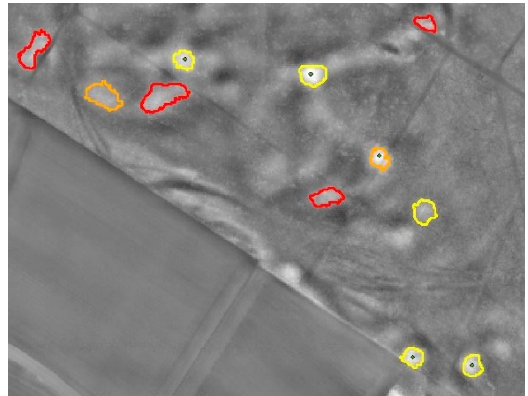
Figure 18. Classification results of Burial Mounds in Haltern. Members from the following classes are presented (Table 8); 3 (yellow), 4 (orange) and 5 (red). Mounds with a dot are included in the reference dataset. The yellow traced mound on the right side without a dot inside is considered as a new discovery ( new positive ) [13].